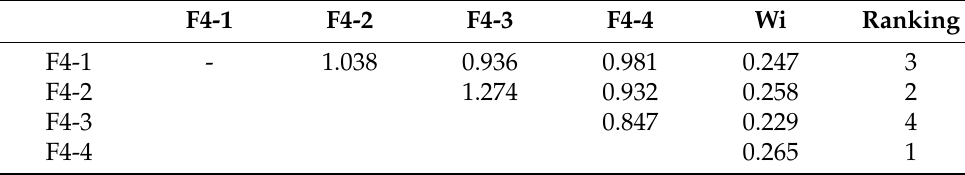
Table 11. Ranking of secondary factors in the “green diversified